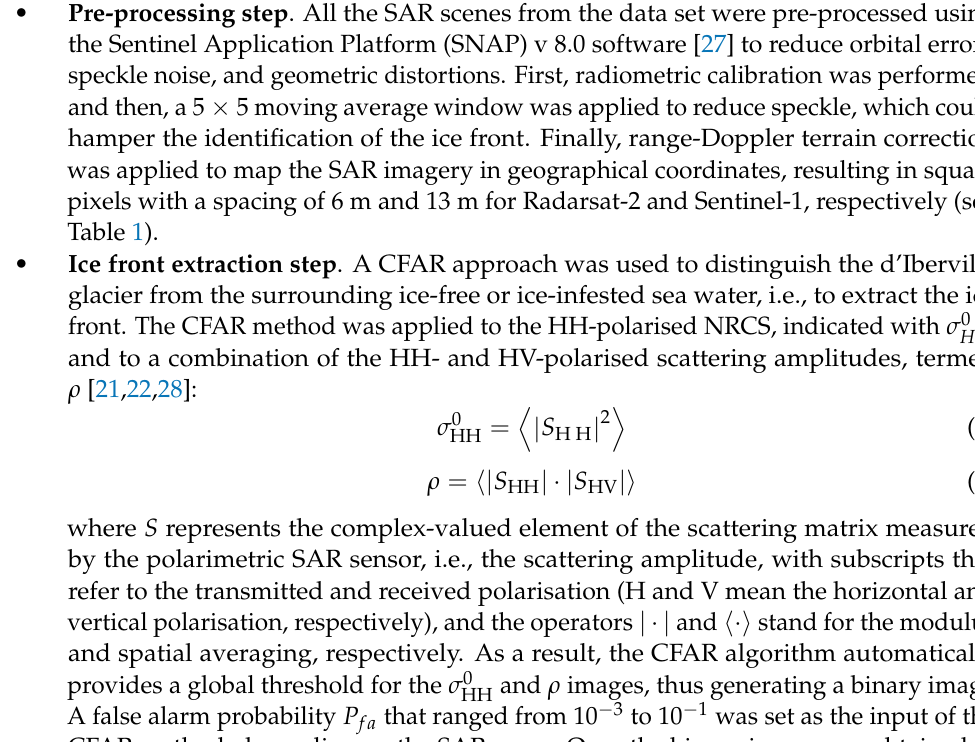
Figure 2. Flowchart of the